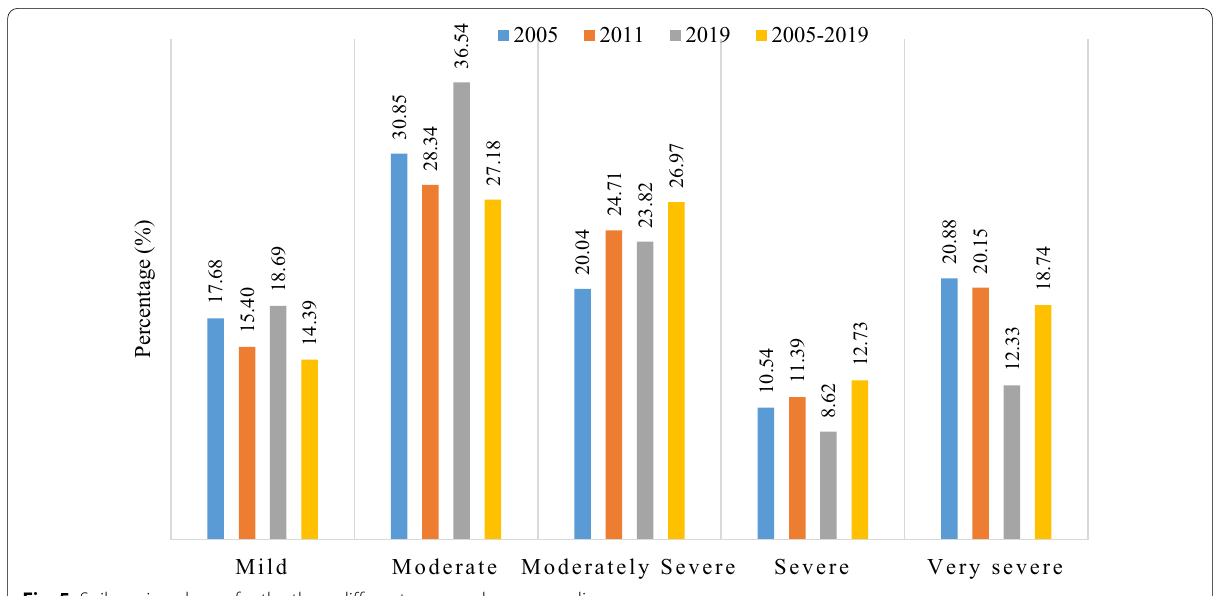
Fig. 5 Soil erosion classes for the three different years and corresponding